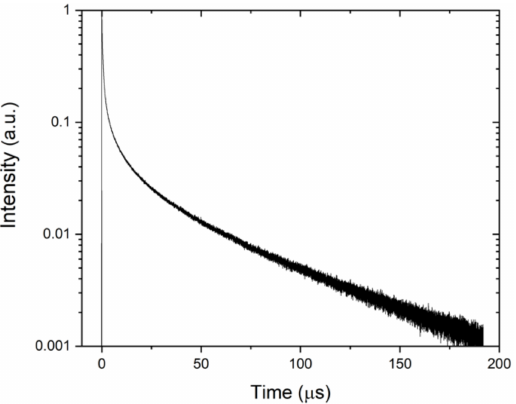
Figure 8. Temporal evolution of the upconversion emission of 530 nm of Nd 3+